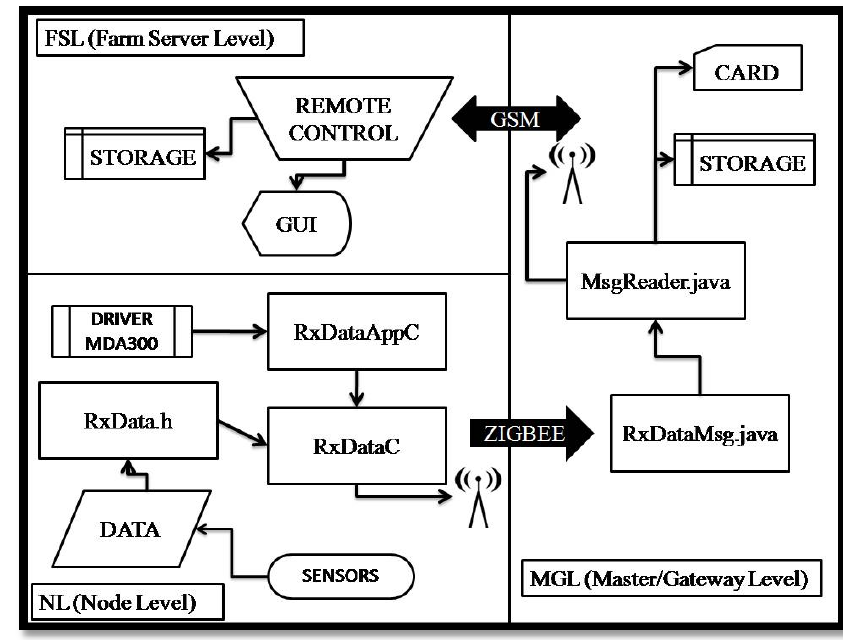
Figure 3. Block diagram of the hardware connections and software